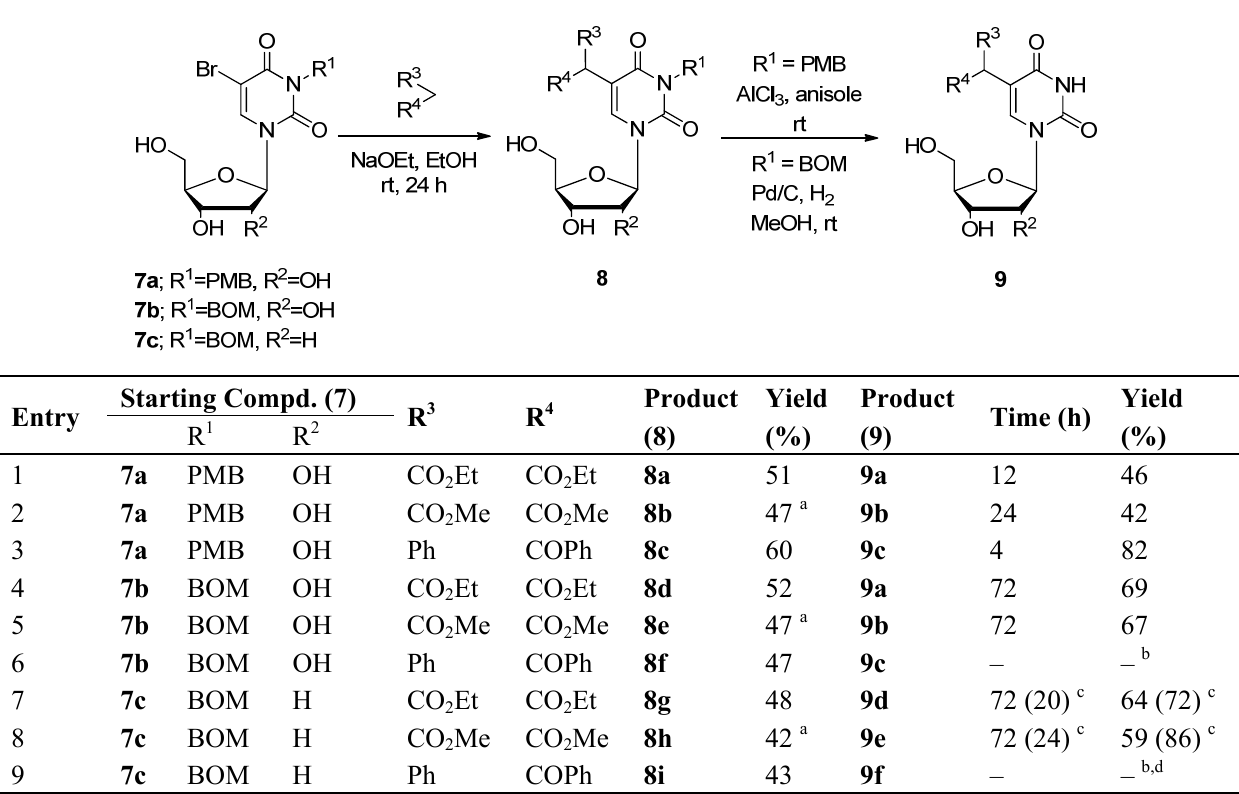
Table 3. Preparation of 5-substituted uridine